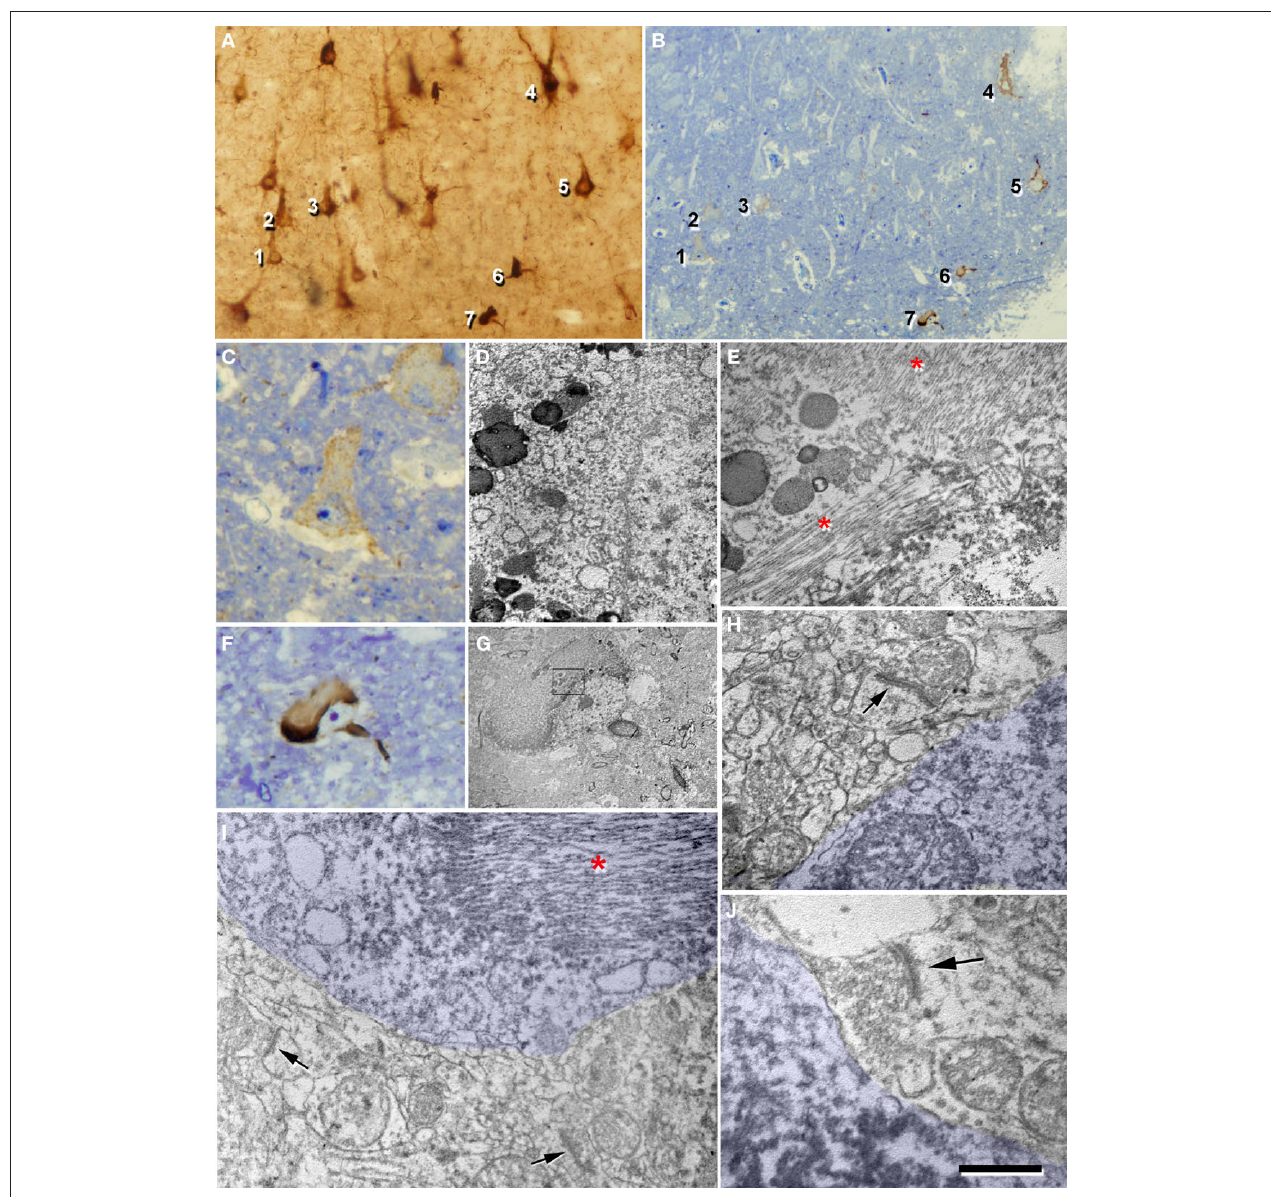
FiGure 14 | Correlative light and electron microscopy of PHF-tau-ir neurons in the pyramidal layer of CA1 from patient P1. (A) Photomicrograph of a plastic-embedded 100 μm-thick section immunostained for PHF-tau. (B) Photomicrograph of a 2-μm-thick semithin section stained with 1% toluidine blue obtained from the section shown in (A) . (C) , (F) , higher magnification of cells 1 (pattern I of PHF-tau-immunostaining) and 7 (pattern II of PHF-tau- immunostaining), respectively, also shown in (A) and (B) . (D) , (e,G) , electron micrographs of neurons 1 and 7, respectively, obtained after the resectioning of